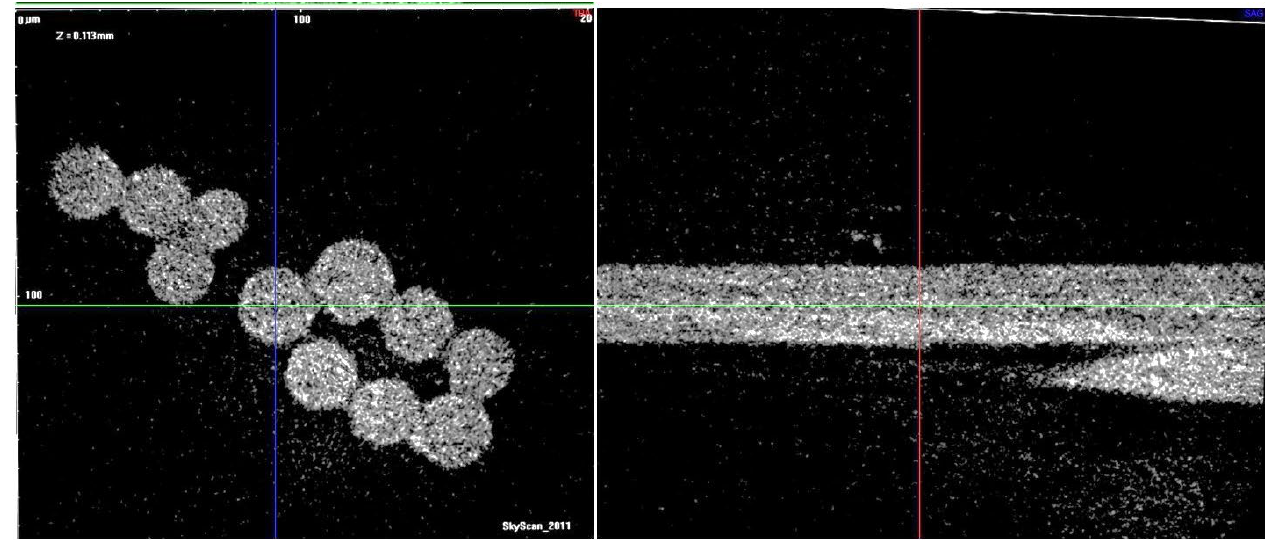
Figure 3. Interperpendicular sections of PCS fibers.